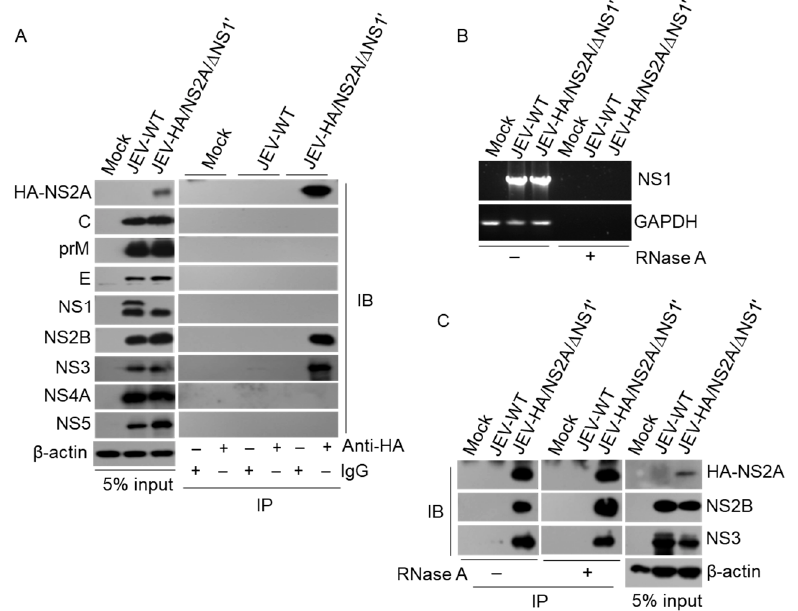
Figure 5. Interaction of HA-NS2A with viral proteins. BHK-21 cells were infected with JEV and harvested at 48 hpi for a co-immunoprecipitation assay. ( A ) The cell lysates were incubated with anti-HA antibodies and the immunoprecipitated proteins were detected with the indicated antibodies against different viral proteins. ( B ) The cell lysates were pre-treated with RNase A and the presence of NS1 and GAPDH RNAs was examined by RT-PCR. ( C ) The cells lysates were pre-treated with RNase A and subsequently subjected to co-immunoprecipitation with anti-HA antibodies. The immunoprecipitated proteins were detected by the indicated antibodies against different viral proteins.